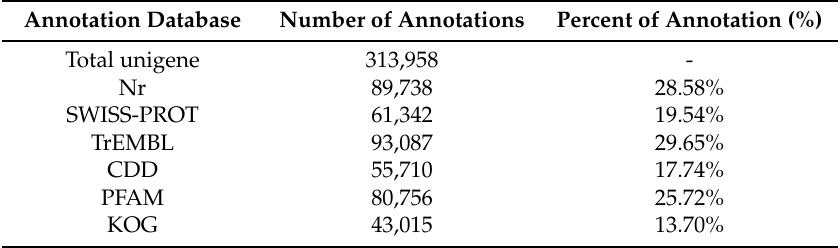
Table 2. List of